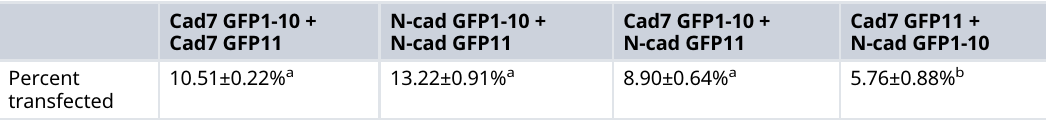
Table 1. Transfection efficiency of Cadherin split GFP